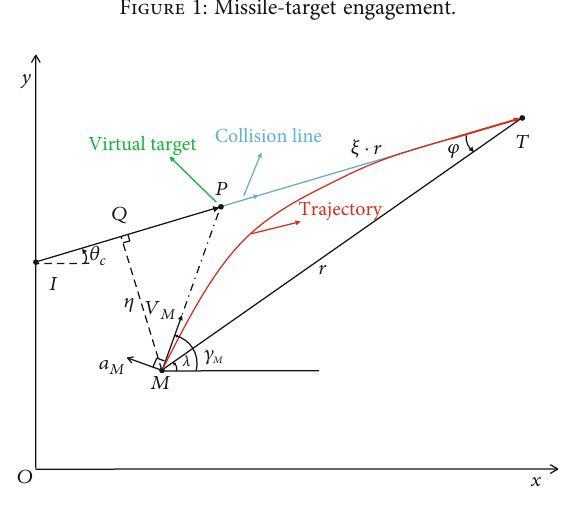
Figure 2: Stationary